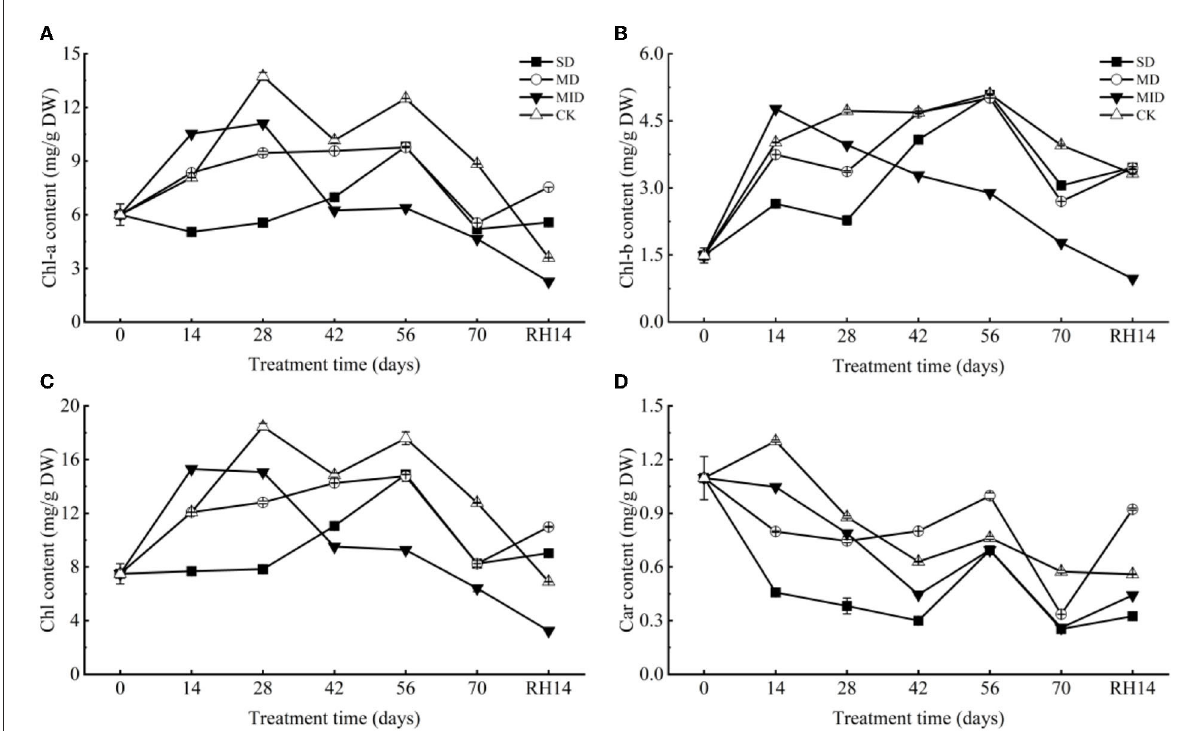
FIGURE7 The photosynthetic pigment during the drought and rehydration for A. selengensis . Fourteenth day of rehydration (RH, 14 days), chlorophyll a (Chl-a), chlorophyll b (Chl-b), total chlorophyll (Chl), carotenoids (Car). The severe drought group (SD), the moderate drought group (MD), the mild drought group (MID), the control group (CK). (A) Chl-a of A. selengensis . (B) Chl-b of A. selengensis . (C) Chl of A. selengensis . (D) Car of A. selengensis